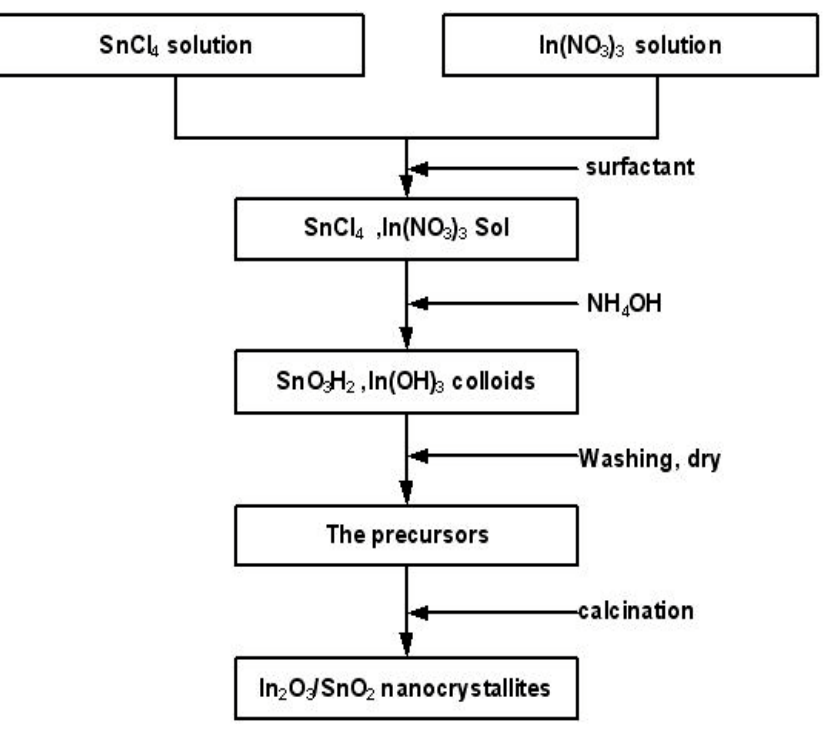
Figure 1. Preparation process of In